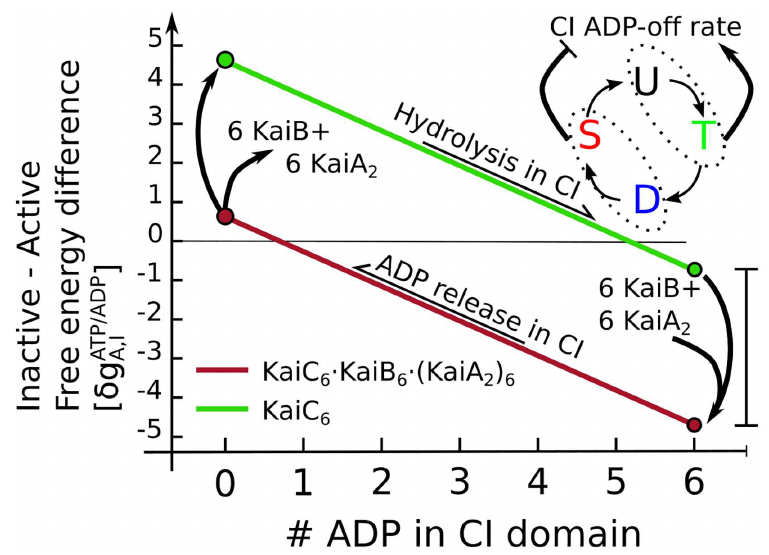
Fig 5. Hydrolysis of ATP in the CI domain, and the subsequent binding of KaiB and KaiA, forms a hysteresis loop in the free-energy difference between the active and inactive state. Starting in the active state with no ADP bound to CI, the free-energy difference linearlydecreases as ATP is hydrolyzedto ADP, as indicatedby the green line. The number of ADP in CI is set by the competitionbetweena fixed hydrolysisrate and a variable ADP off-rate, which is set by the phosphorylationstate of the CII domainsof the whole hexamer. Phosphorylationof the T site initiallyenhances the ADP off-rate, but the subsequent phosphorylation of the S-site will decreasethe dissociationof ADP. The antagonistic effect of the cyclically phosphorylated T and S sites on the ADP dissociationrate causes a sharp transition in the CI bindingpocket from ATP dominated to ADP dominated [24]. When there are 5 or 6 ADP nucleotides in the CI domain,the hexamerwill flip to the inactive state, increasing the affinity for KaiB, which will then slowlybind inactive KaiC. When 6 KaiB monomers are bound to the hexamer, up to six free KaiA dimers will be sequestered from solution.This complexof KaiB and KaiA on the CI domain stabilizesthe inactive state of KaiC further (red line). When all KaiA is sequestered, the dephosphorylation of the S-site in the CII domainwill increasethe nucleotide exchangerate in the CI domain, decreasing the ADP level and increasing the free-energy difference betweenthe active and inactive state. This allows the hexamerto flip back to the active state. In the active state, KaiA and KaiB dissociatefrom KaiC, becausethey have a low affinity for CI in the active